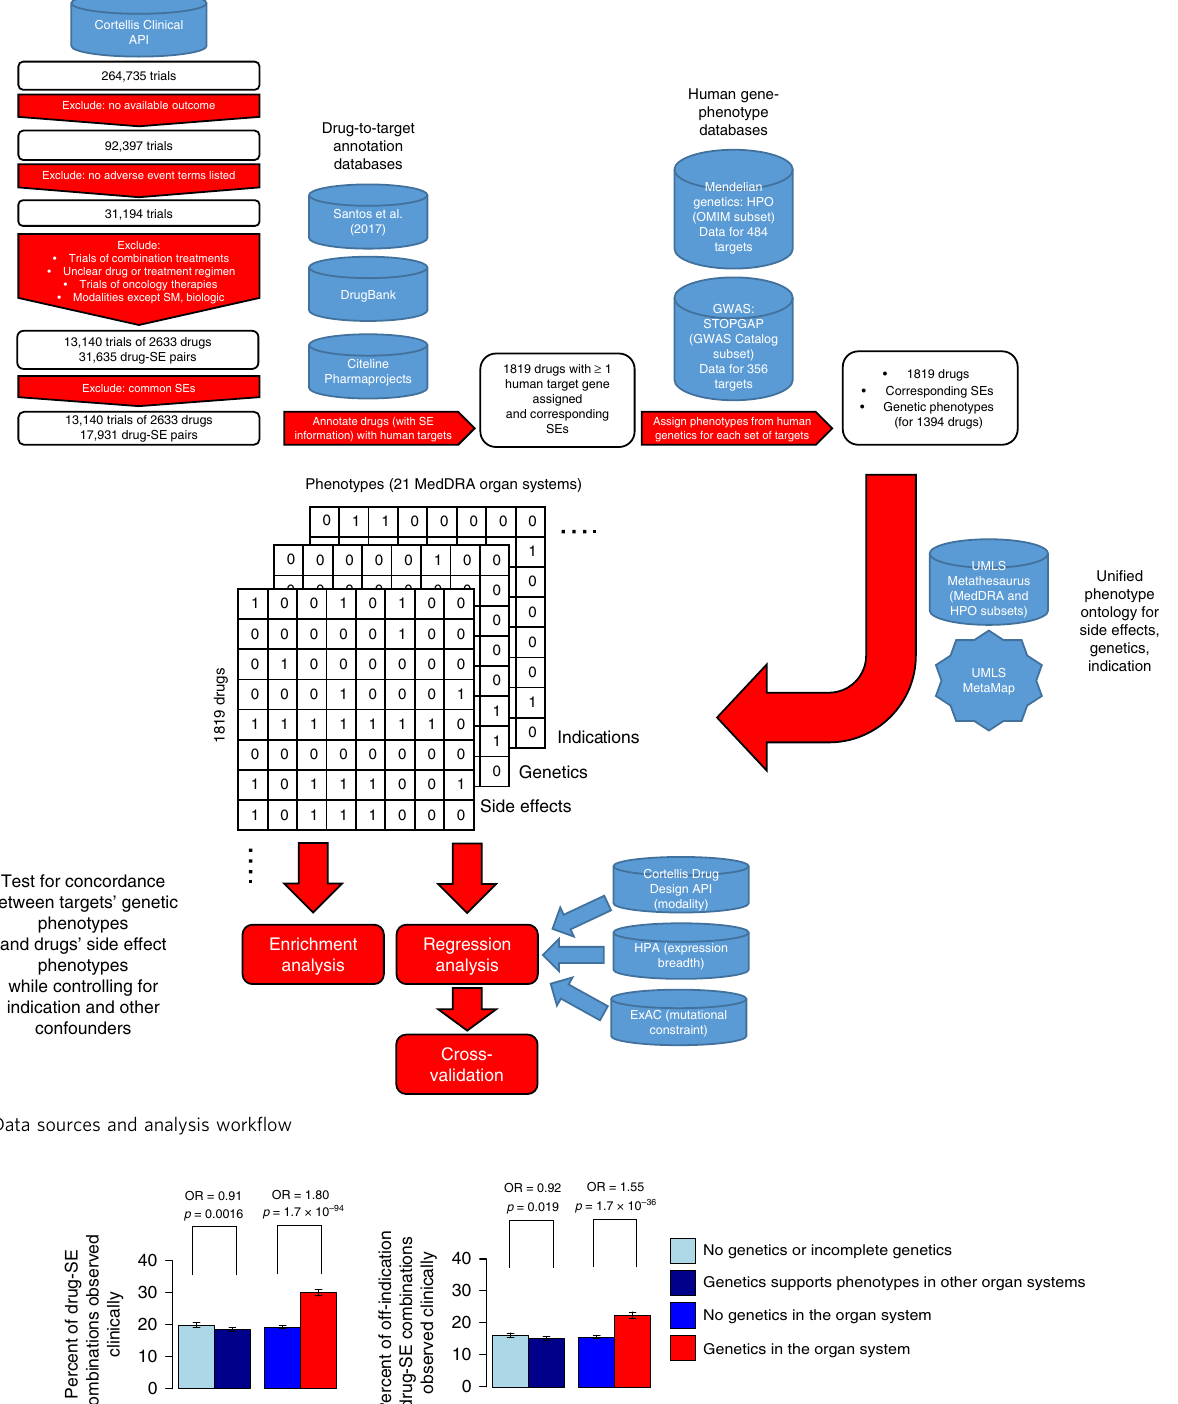
Fig. 2 Rate of side effect (SE) manifestation across drug-SE combinations classi fi ed by genetic support. OR, odds ratio; P , P -value from Fisher ’ s exact test (two-tailed). The left panel shows analyses based on all 38,199 drug-SE combinations; the right panel shows analyses based on 33,489 “ off-indication ” drug-SE combinations. Error bars represent the 95% con fi dence interval of the reported proportions. Source data and con fi dence intervals for the OR values are shown in Supplementary Table 1. Similar analyses for Mendelian and GWAS genetics separately are shown in Supplementary Figure 4